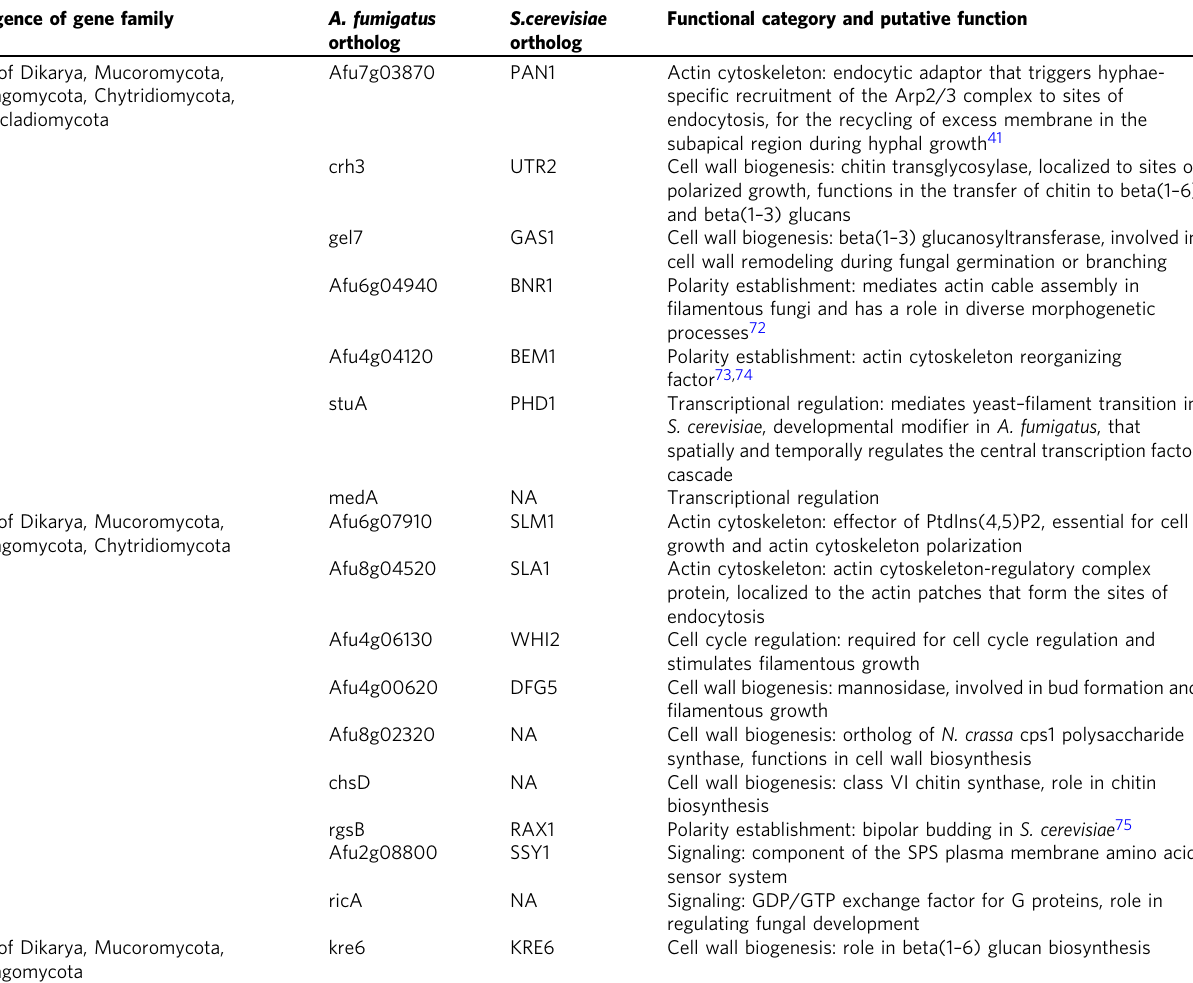
Table 1 List of the 17 gene families whose emergence coincides with the evolution of hyphae Emergence of gene